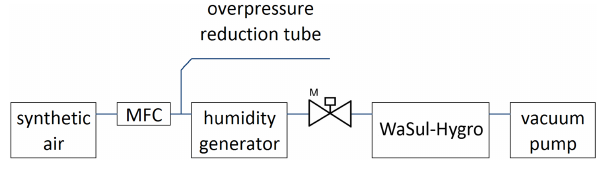
Figure 2. The schematic layout of the calibration system. MFC stands for mass flow controller and M is the stepper motor- controlled needle valve (see text for